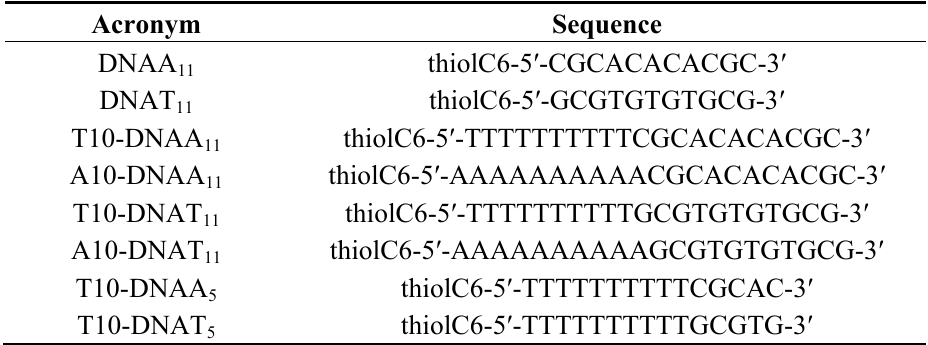
Table 1. Acronym and sequence of the oligonucleotides used to functionalize the gold nanoparticles